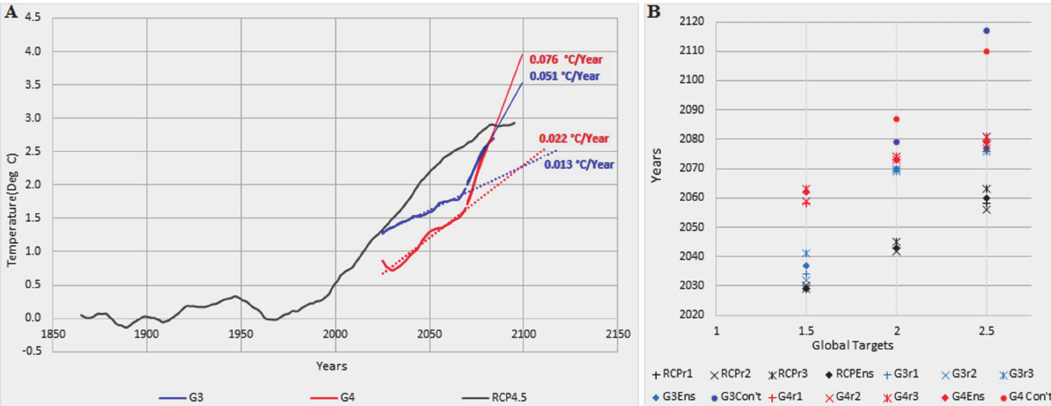
Figure 3. ( A ): World temperature anomaly (with respect to 1860 to 1900) for ensemble mean of HadGEM2-ES_unaltered runs under RCP4.5 (solid black line) and HadGEM2-ES under G3 (solid blue line) and G4 (solid red line) conditions. Shown as well are the trend lines and the corresponding rates of temperature increase if SRM is continued onward from 2070 (dotted lines) and for the sharp rise in temperature that is projected after SRM is discontinued in 2070 (solid thin lines). ( B ): Years when global average temperatures are expected to reach 1.5, 2.0 and 2.5 ◦ C for unaltered and SRM-altered HadGEM2-ES. Results are for three realizations and the ensemble mean. Shown also are the years when G3 and G4 HadGEM2-ES (G3_Con’t and G4_Con’t) reach 2.0 and 2.5 ◦ C if SRM is continued after